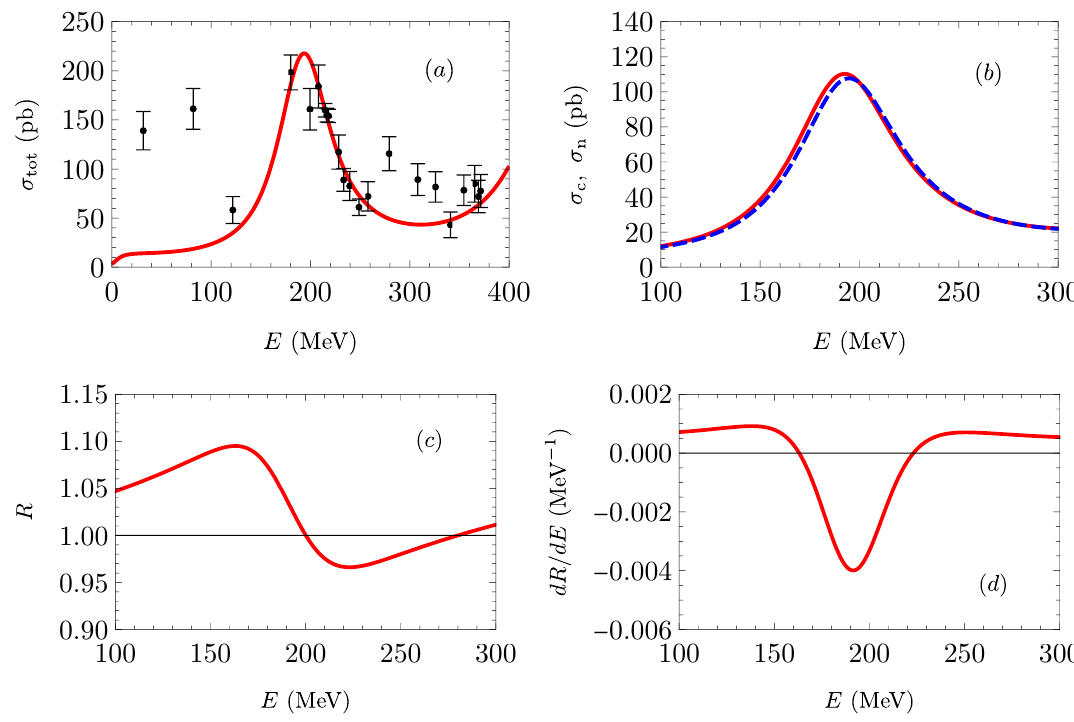
Figure 1 . Cross sections of B ∗ ¯ B ∗ meson production for a = 2 . 5 fm, V 0 = 1198 MeV. (a) Energy dependence of σ tot = σ c + σ n . (b) Energy dependence of σ c (solid curve) and σ n (dashed curve) near the Υ(5 S ) resonance. (c) Energy dependence of the ratio R = σ c /σ n near the Υ(5 S ) resonance. (d) Energy dependence of dR/dE near the Υ(5 S ) resonance. Experimental data are from ref.